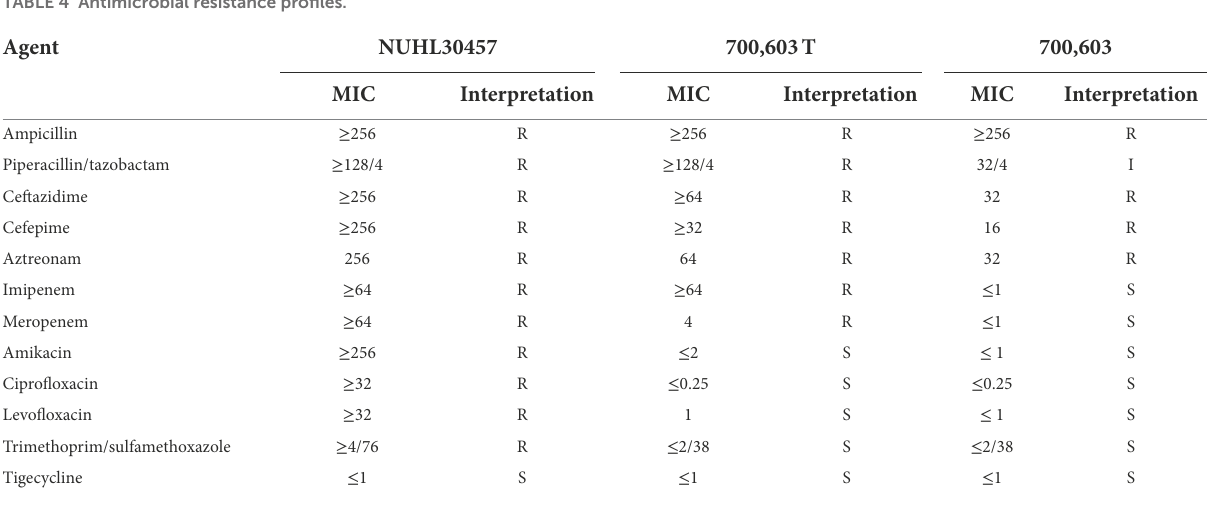
TABLE 4 Antimicrobial resistance